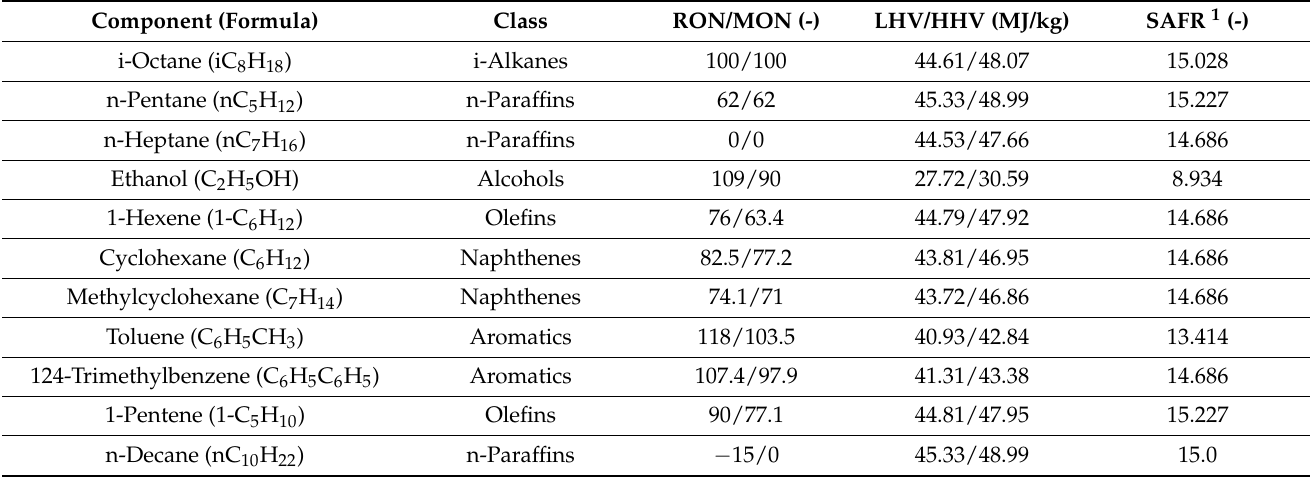
Table 3. Palette of the chemical species chosen for chemical kinetics simulations and their properties.